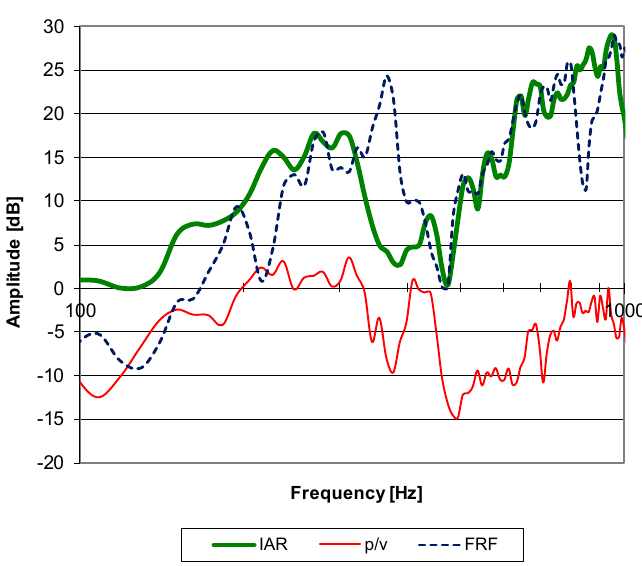
Figure 4. Carabattola : FRF compared with p / v and IAR.